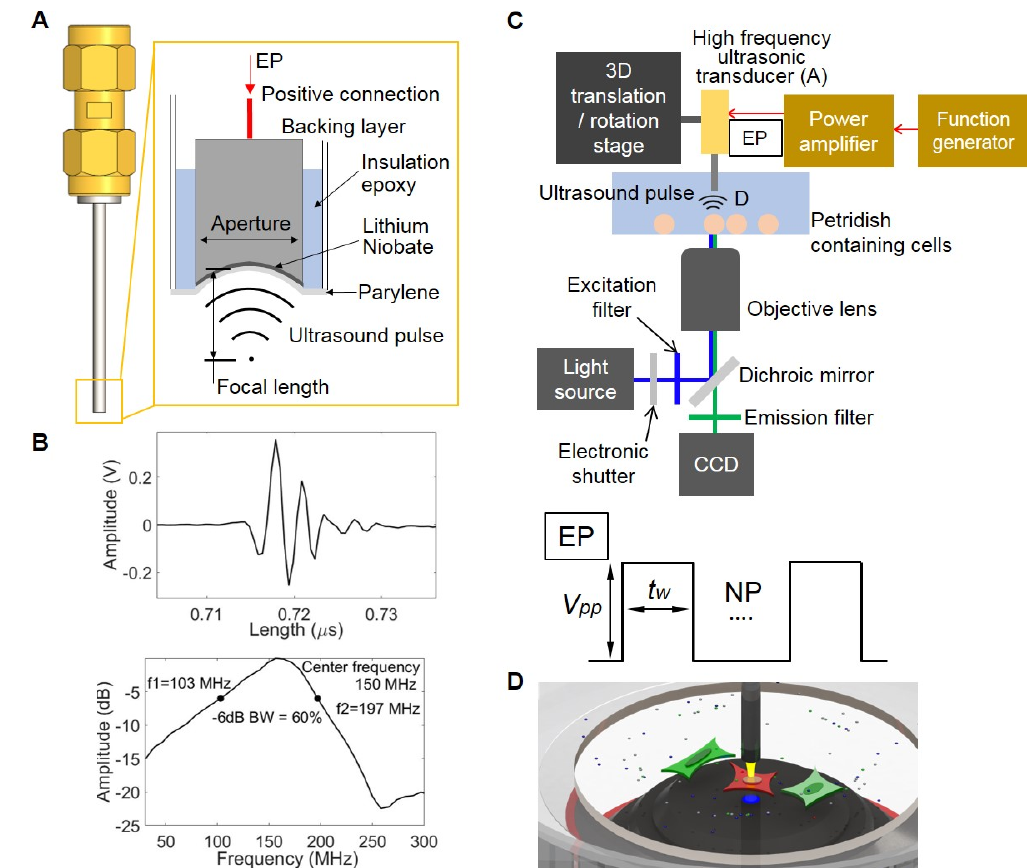
Figure 2. High-frequency ultrasonic transducer and integrated system for the intracellular delivery and stimulation. ( A ) Schematic diagram of 150 MHz ultrasonic transducer shows SMA connector (yellow part) and needle type transducer (grey part) for cell manipulation. Lithium niobate (LibNO 3 ) was used to generate 150 MHz ultrasound pulse for the intracellular delivery and stimulation. Aperture (1 mm) was focused to have 1 mm focal depth with fnumber of 1. Electrical pulse (EP) was applied through positive connection to trigger LibNO 3 . ( B ) Experimentally measured echo and its spectrum of the developed transducer shows that actual center frequency was 150 MHz. ( C ) An integrated system for the intracellular delivery and stimulation of target cells was comprised of a fluorescence microscope and a high frequency ultrasound transducer shown in A. A function generator and a power amplifier generated EP to excite the high frequency ultrasound transducer. Peak-to-peak voltage ( V pp ) and pulse duration ( t w ) are controlled by a function generator. Number of pulses (NP) is the total number of ultrasound pulses to target cells. The location of the transducer was controlled by a 3D translation / rotation stage. ( D ) Target cell in red is being treated by ultrasound pulse generated by high frequency ultrasonic transducer. For the intracellular delivery of macromolecules, small molecules can be presented in the same Petri dish. Yellow cone between the transducer tip and the target cell indicates ultrasound pulse (not to